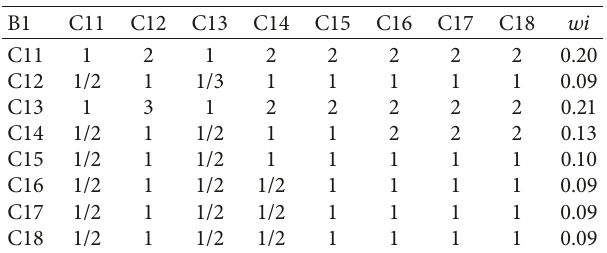
Table 9: Weights of indicators in B2-C and layer C of